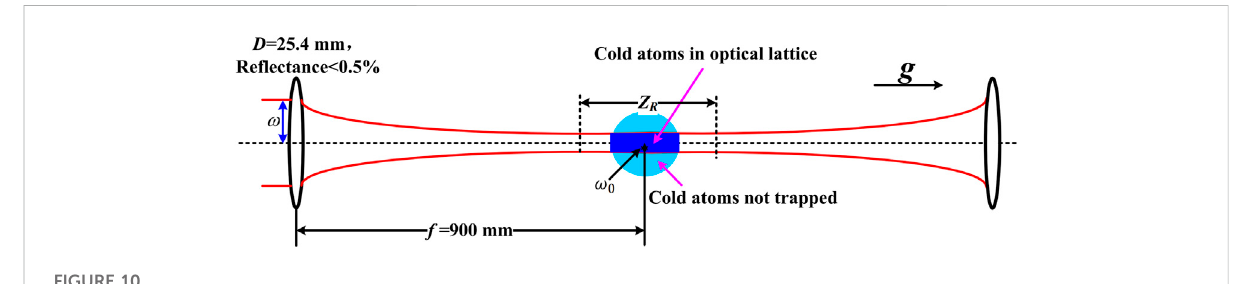
FIGURE 10 The schematic diagram of optical path for optical lattice.